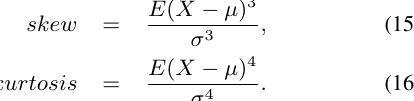
Figure 2. Curves of probability density functions expressed by Equation